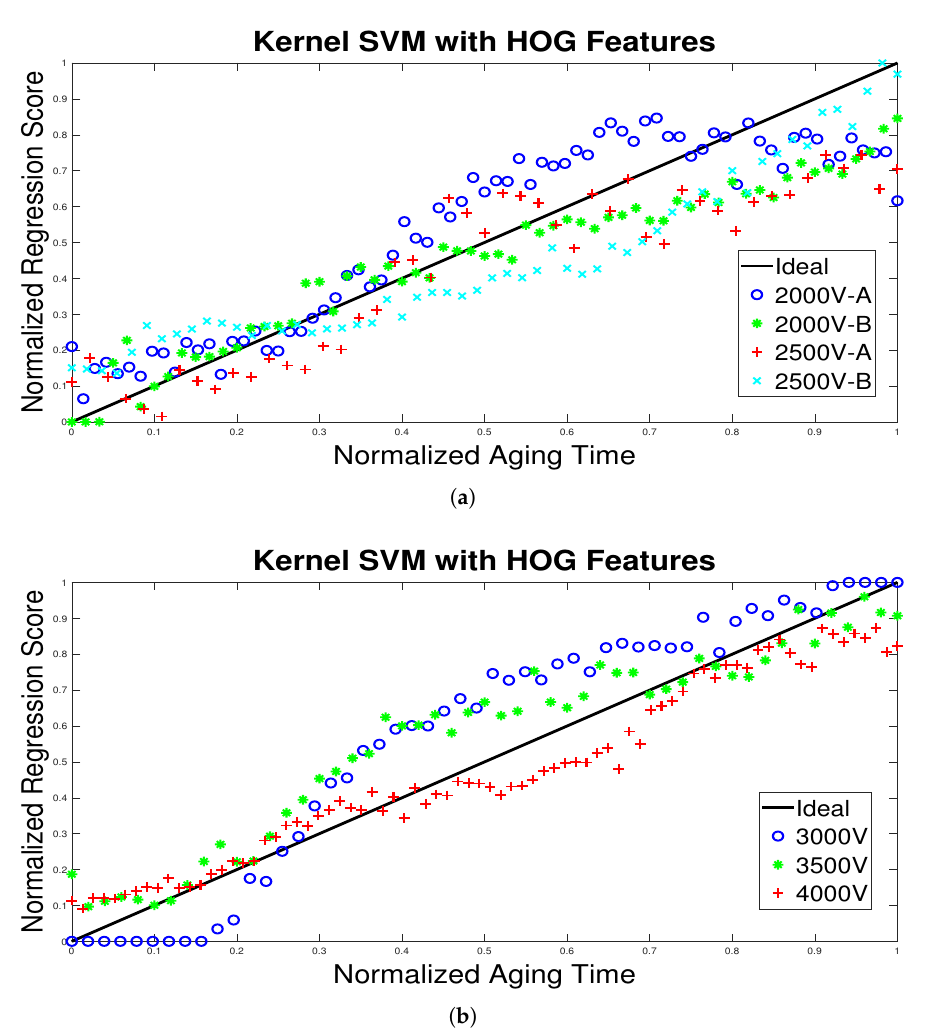
Figure 8. Kernel SVM results with HOG features with a power supply in the range [ 2000 2500 ] V ( a ) and in the range [ 3000 4000 ] V ( b